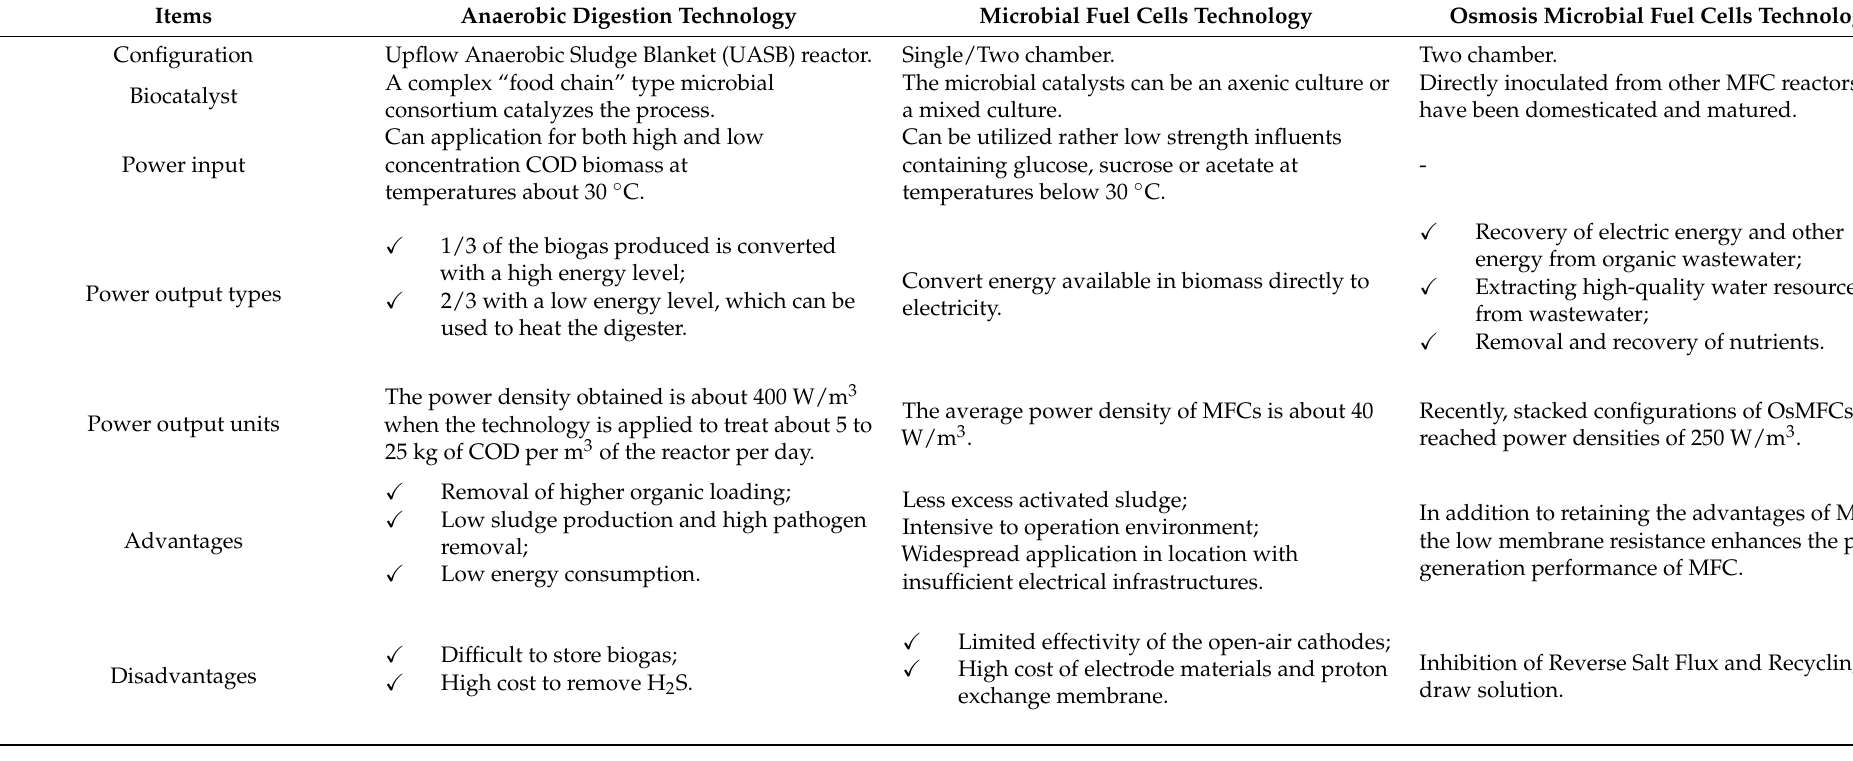
Table 2. Comparison of conventional anaerobic digestion technology with microbial fuel cells technology and forward Osmosis Microbial fuel cells technology